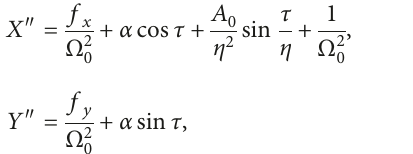
Table 1: The expression of nondimensional parameter. Parameter description Expression